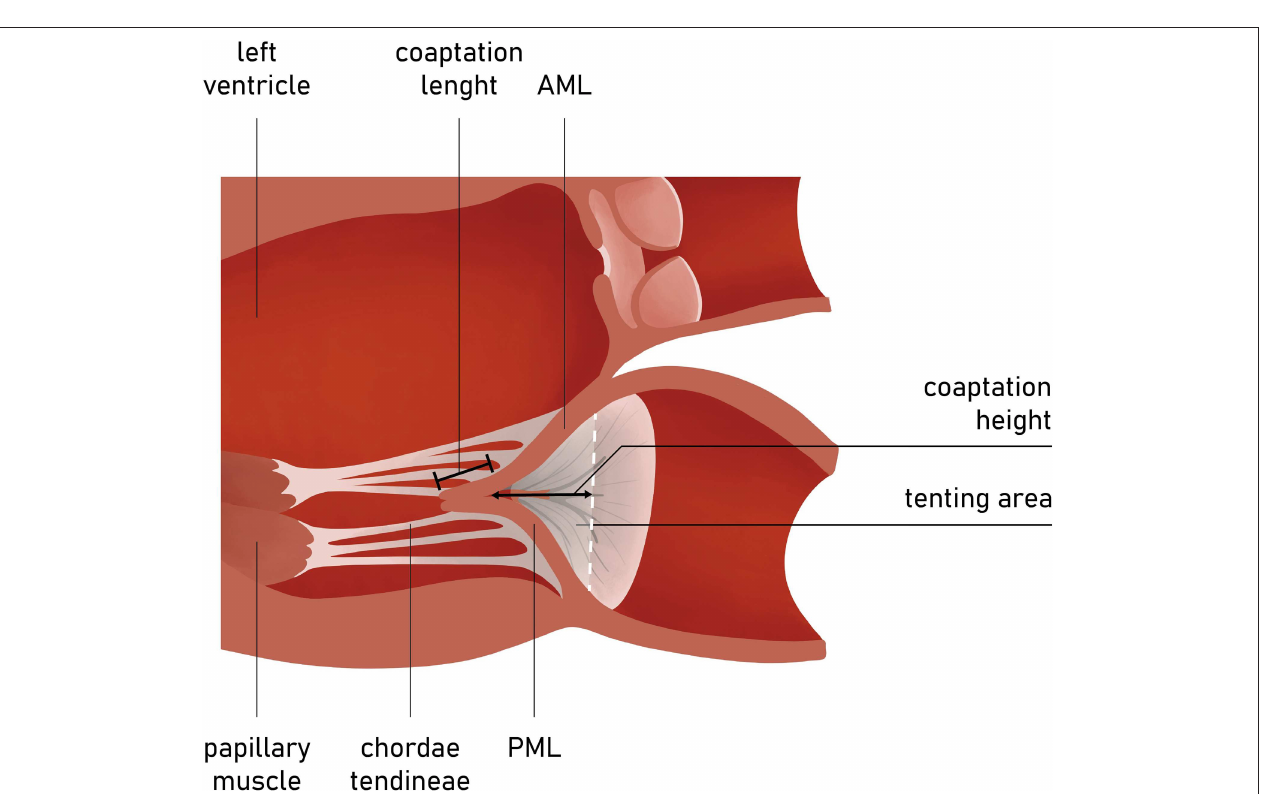
and transcatheter annuloplasty depends on shifting the posterior annulus anteriorly, reducing the septolateral distance and increasing the coaptation area. However, this mechanism does not settle anteriorly the coaptation point, since the posterior leaflet struggles being tethered posteriorly and its anterior excursion is noticeably limited. This phenomenon of “freezing of posterior leaflet” is always present after annuloplasty and does not affect the anterior leaflet (AL) motion, so that valve closure becomes essentially a “single-leaflet process” and the frozen posterior leaflet (PL) serves only as a support for the closure